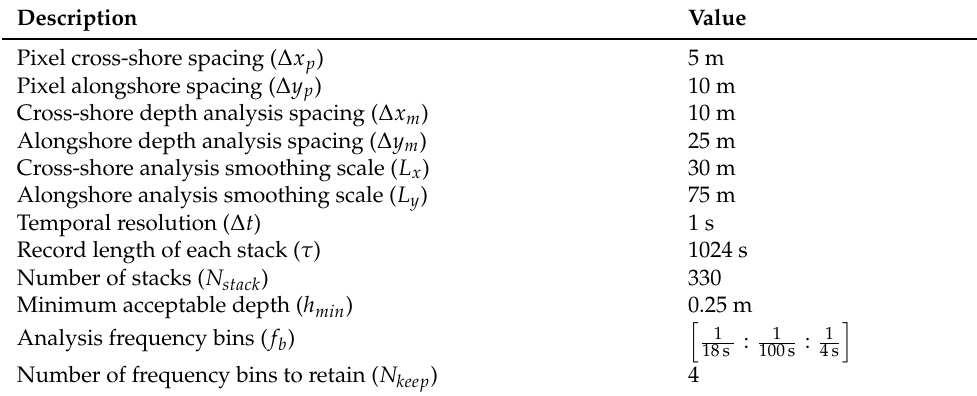
Table 2. cBathy parameters used for October 2018 field